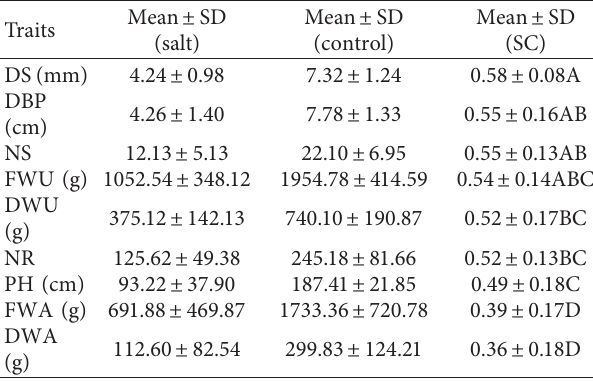
DS: the diameter of the stalk; DBP: the diameter of the basal plate; NS: the number of stalks; FWU: the fresh weight underground; DWU: the dry weight underground; NR: the number of roots; PH: plant height; FWA: the fresh weight of the aboveground part; DWA: the dry weight of the aboveground part. Values with different capital letters in the last column indicate a significant difference ( P < 0 .